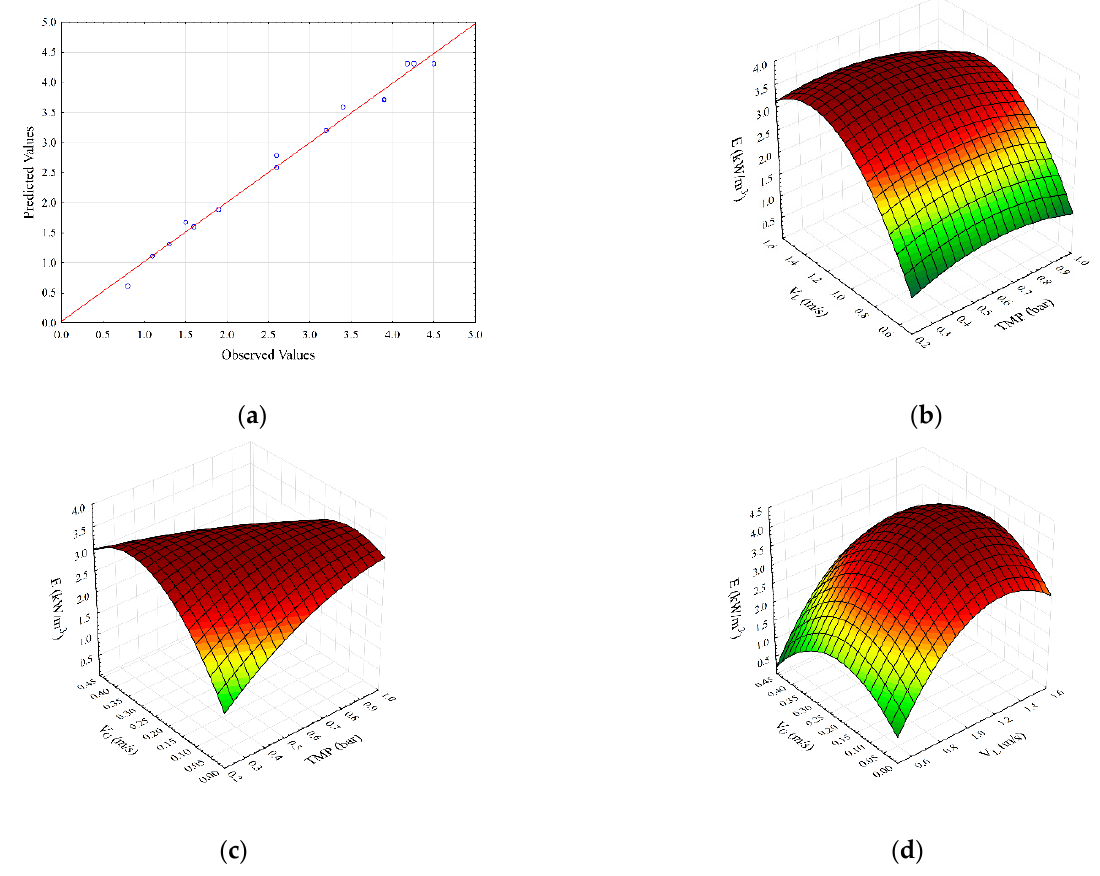
Figure 2. Parity plot ( a ) and response surface plots ( b – d ) representing the regression model for specific energy consumption during SMGS microfiltration of Bacillus velezensis IP22 cultivation broth.